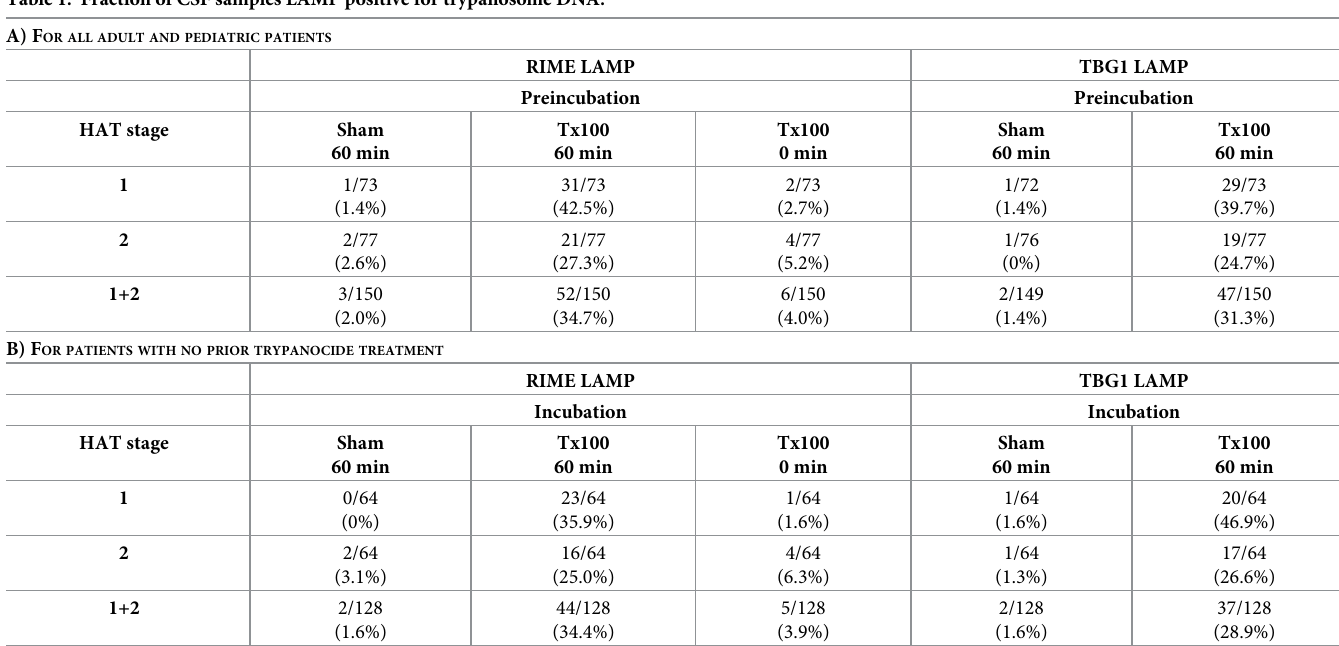
Table 1. Fraction of CSF samples LAMP positive for trypanosome